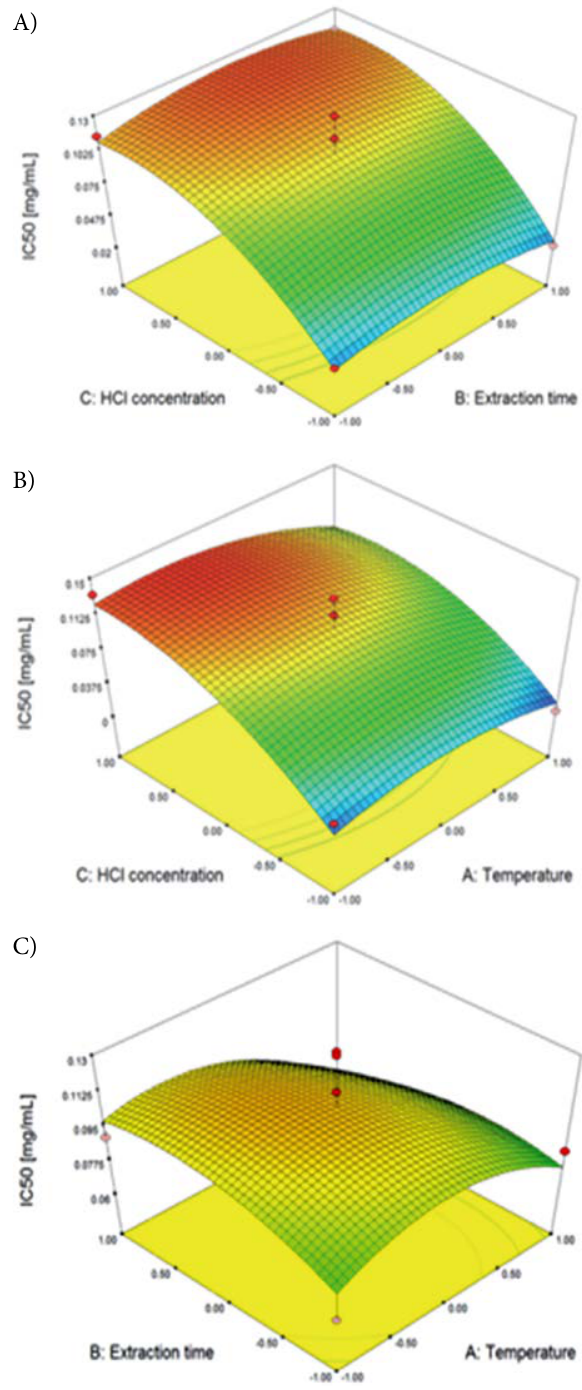
Figure 5 Response surface plots showing combined effects of pro- cess variables: (A) HCl concentration and extraction time, (B) HCl concentration and temperature and (C) extraction time and tem- perature on IC 50